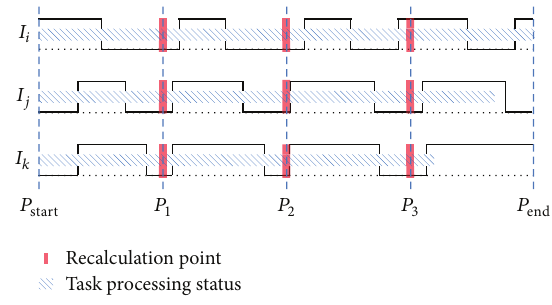
Figure 3: The recalculation point of the task